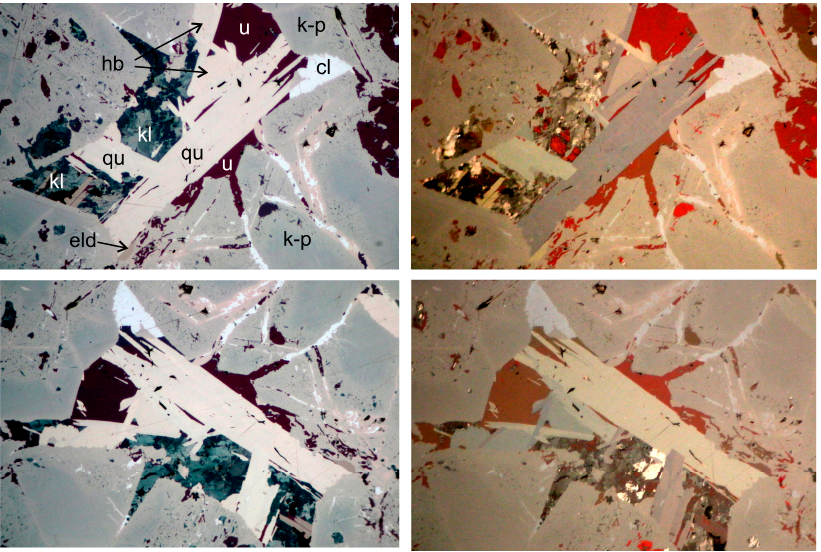
Figure 3. Reflected light digital images of quijarroite (qu) in association with hansblockite (hb), clausthalite (cl), krut’aite-penroseite (k-p), klockmannite (kl), umangite (u), and eldragónite (eld). Horizontal field of view is 200 µm. Left images: one polarizer; right images: Partly crossed polarizers.